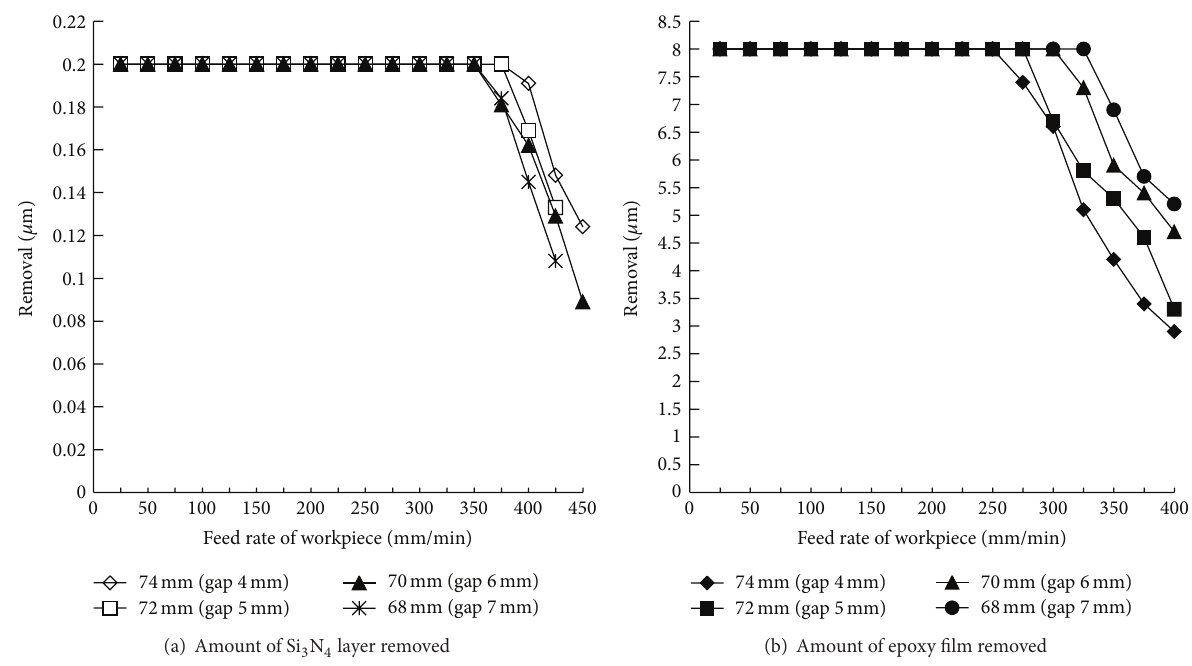
Figure 9: Amount of Si 3 N 4 layer and epoxy film removed at different feed rates of workpiece using different diameters ( D different sizes of gap between the anode and cathode (phosphoric acid 25% wt, NaNO 3 15%wt, PO4-3-P 5% wt, 60 ∘ C, 40L/min, continuous DC, 150A, 100kHZ/150W, 4000 Gauss, shift 800rpm, and tool 900